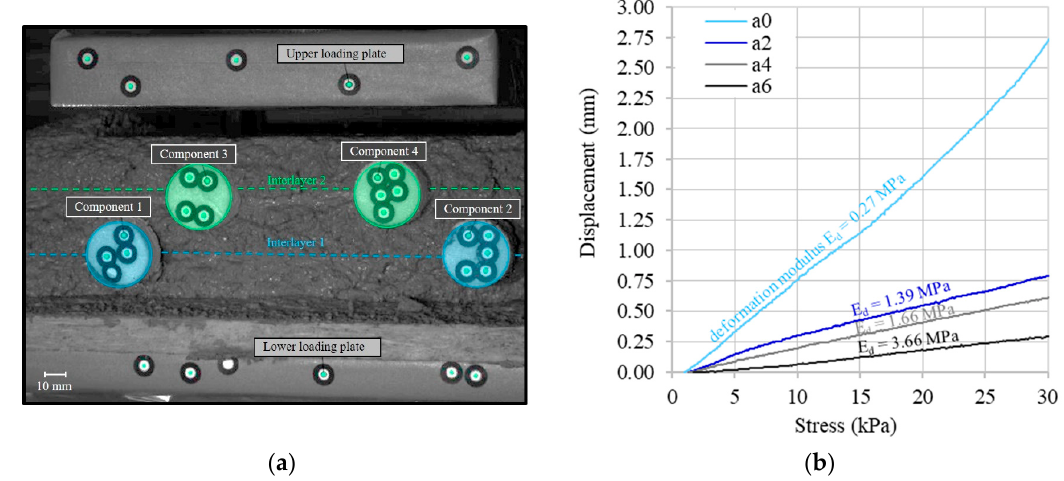
Figure 7. Optical measurement of interlayer displacement; Specimen with inserted reference components ( a ), Displacement–stress curve and deformation modulus of the first interlayer for a0 to a6 10 min after deposition ( b ).